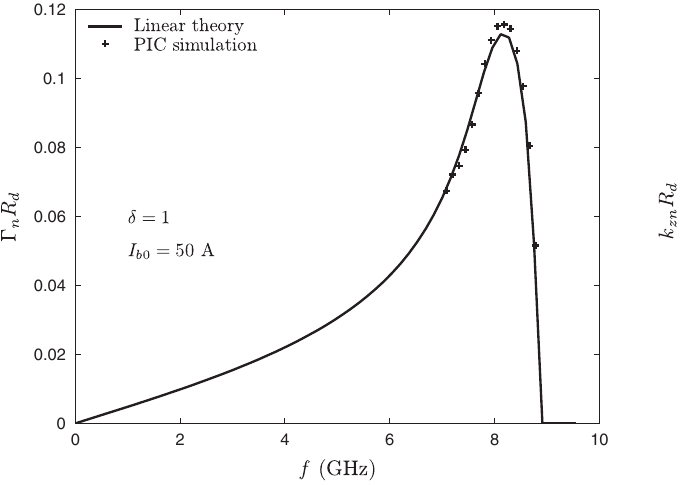
FIG. 16. Normalized spatial growth rates for TM 01 mode for a 50 A beam with (cid:1) ¼ 1